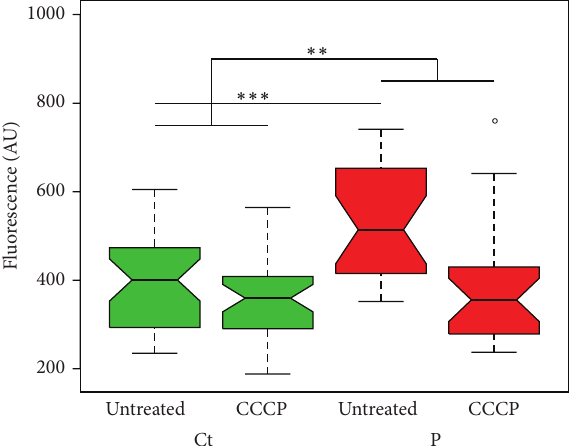
Figure 5: Cell growth in patient-derived and control fibroblasts under basal (untreated) and CCCP-stressed conditions, as assessed by a CyQUANTassay.Boxplotsdepictgroupedpatients(P)andcontrol(Ct)measurementsforthreeexperimentalruns.Patientcellsdemonstrated higher cell growth under basal conditions ( 𝑝 = 0.0001 ). A comparison of the magnitude of the effect of CCCPtreatment within each fibroblast group (i.e., with and without cellular stress) demonstrated that the growth of patient-derived fibroblasts was significantly more suppressed by CCCP than the growth of control fibroblasts ( 𝑝 = 0.0013 ). Fibroblasts from P1 were not available; results pertain to a comparison of P2 and P3 parkin -mutant fibroblast with the three controls. ∗∗ 𝑝 < 0.01 ; ∗∗∗ 𝑝 < 0.001 ; ∘ , outlier; AU, arbitrary